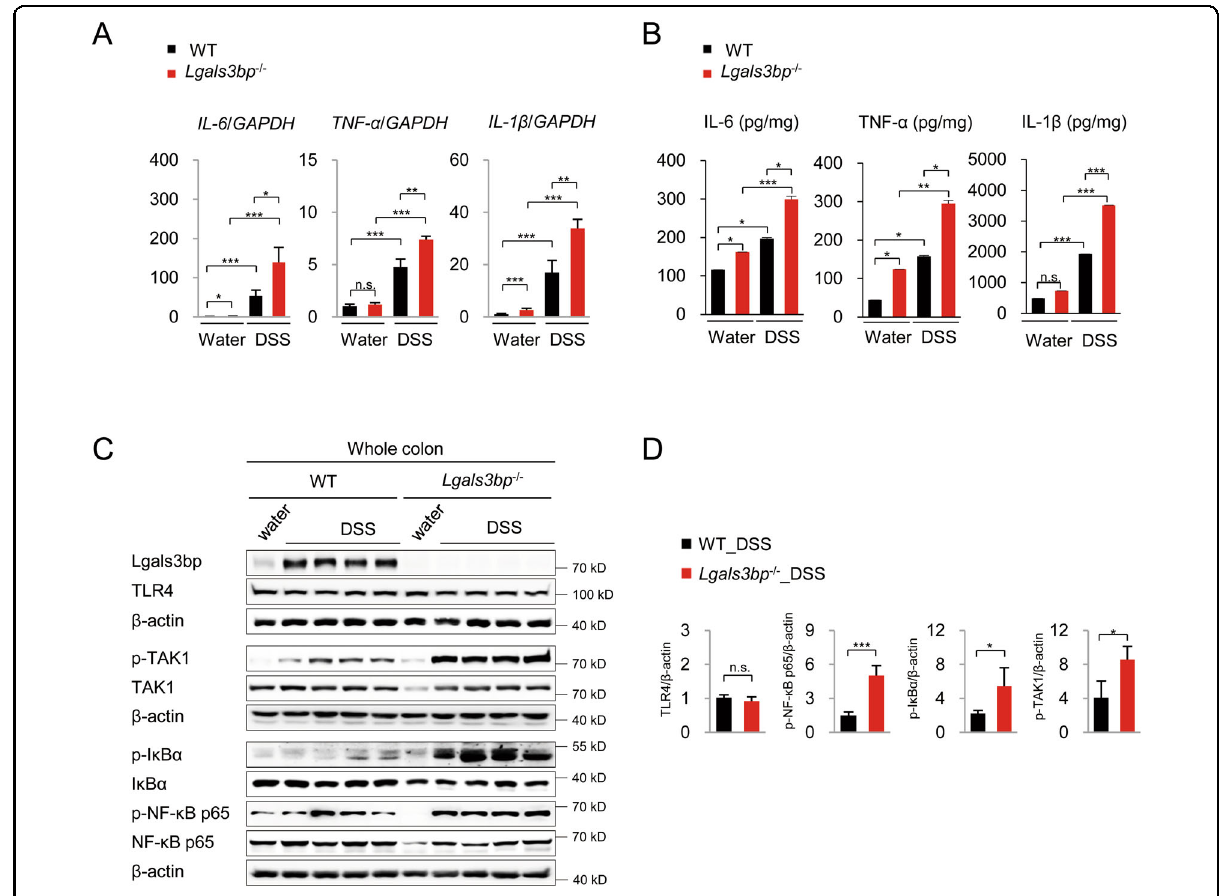
Fig. 3 High in fl ammatory response in the colon during colitis due to Lgals3bp de fi ciency. WT ( n = 7) and Lgals3bp − / − ( n = 7) mice were fed with 2.5% DSS for 7 days and sacri fi ced on day 7. A RNA was isolated from colons, and the expression of the indicated genes was analyzed by RT- qPCR. B The production of IL-6, TNF- α , and IL-1 β in the colon homogenate was tested by ELISA. C Protein extracts of the whole colon from WT and Lgals3bp − / − mice were analyzed for the activation of TAK1, NF- κ B, and I κ B by western blotting. D Densitometric analysis of band intensities of western blots are shown in ( C ). Data are presented as means ± SEM values. * p < 0.05; ** p < 0.01; *** p < 0.001; **** p <